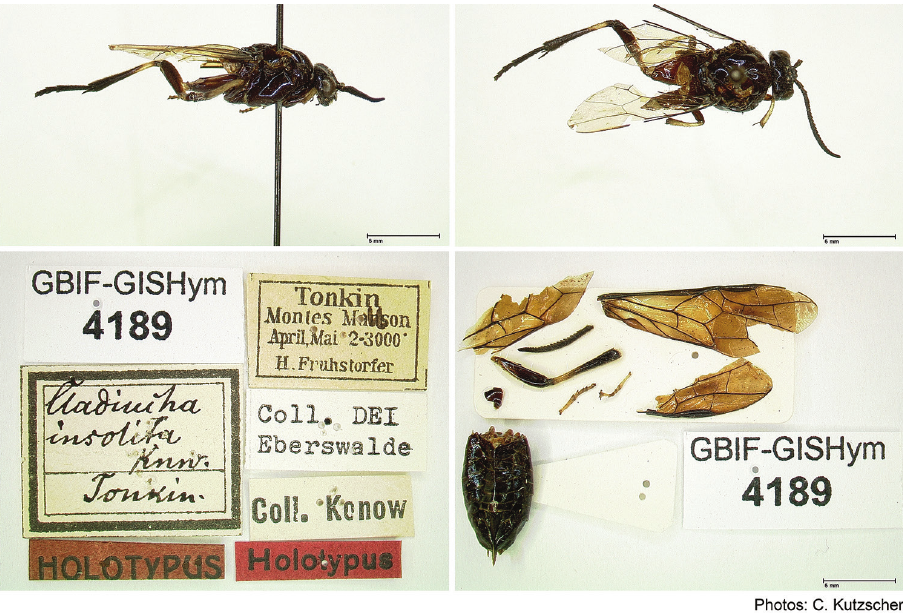
Figure 1. Holotype of Cladiucha insolita . Lateral and dorsal views, labels attached, and broken parts glued onto cardboard beneath specimen (from Taeger and Kutzcher